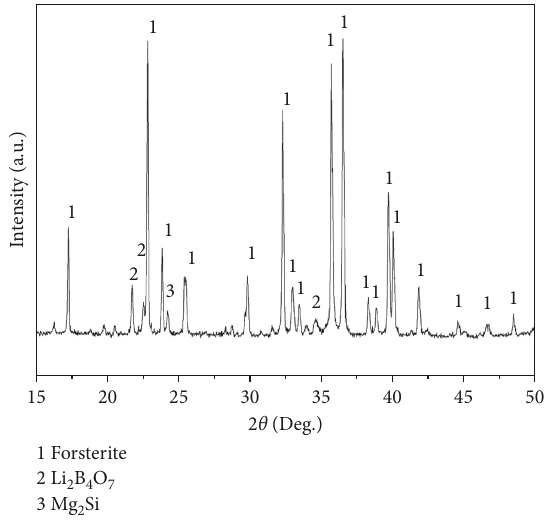
Figure 4: The XRD pattern of (Mg B 2 O 3 –LiF sintered at 1150 ° C.